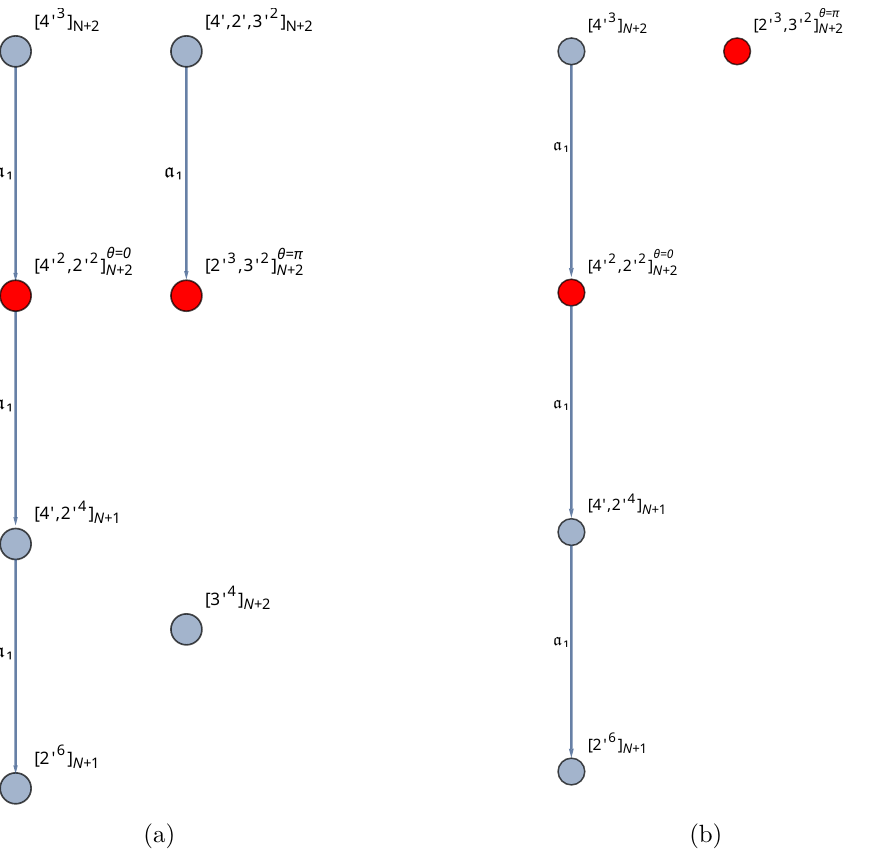
Figure 12. (a) Hierarchy for massive isolated theories. (b) Hierarchy for massive E isolated